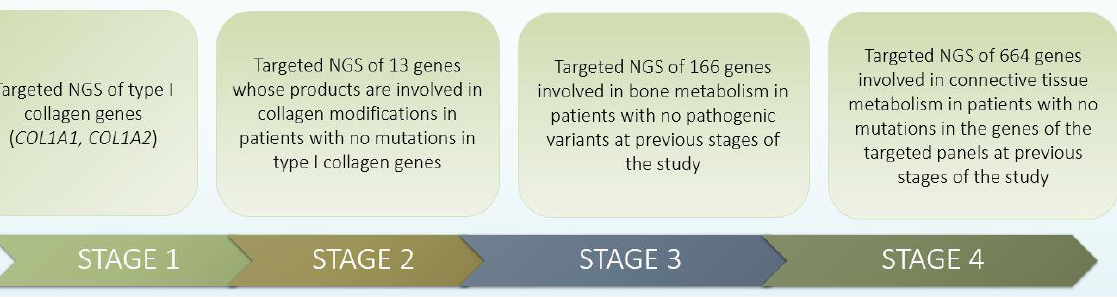
Figure 1. Four stages of research design.